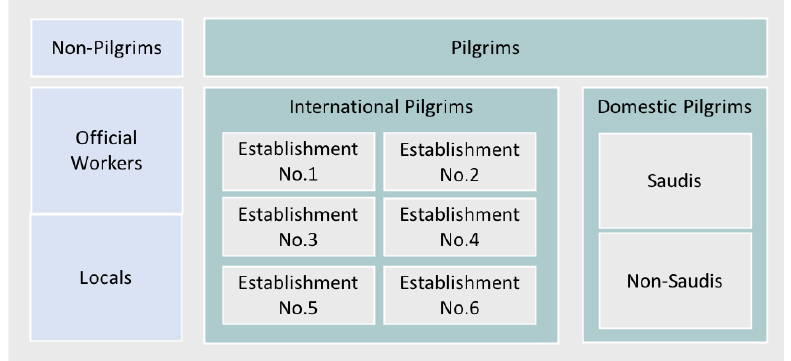
Figure 4. The classification of the sub-populations participate and interact during Hajj